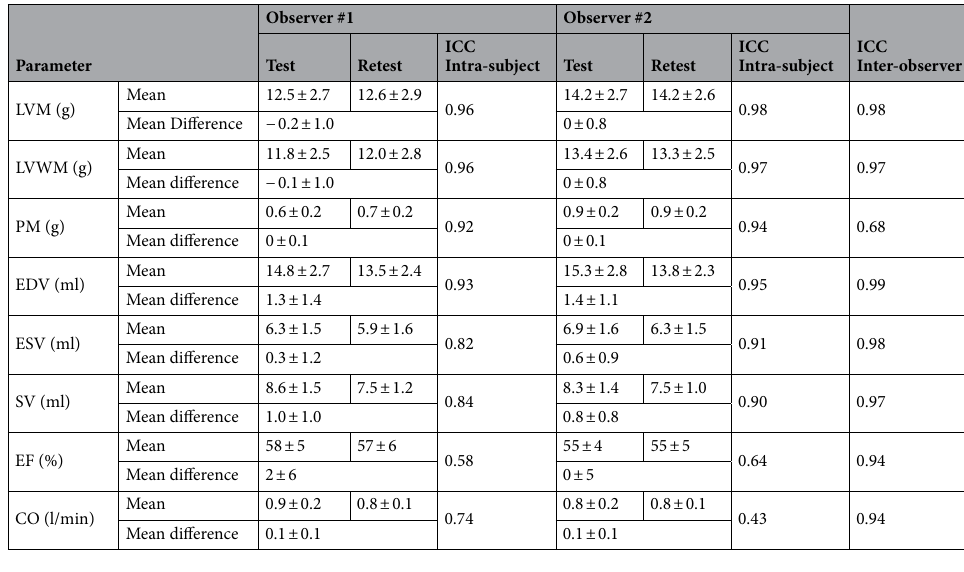
Table 1. Parameters of the left ventricular function assessed by cine MRI. All data given as arithmetic mean and standard deviation (n = 10). Mean difference was defined as the individual differences between test and retest experiment. ICC: Intraclass Correlation Coefficient; LVM: Left Ventricular Mass; LVWM: Left Ventricular Wall Mass; PM: Papillary Muscle Mass; EDV: End-Diastolic Volume; ESV: End-Systolic Volume; SV: Stroke Volume; EF: Ejection Fraction; CO; Cardiac